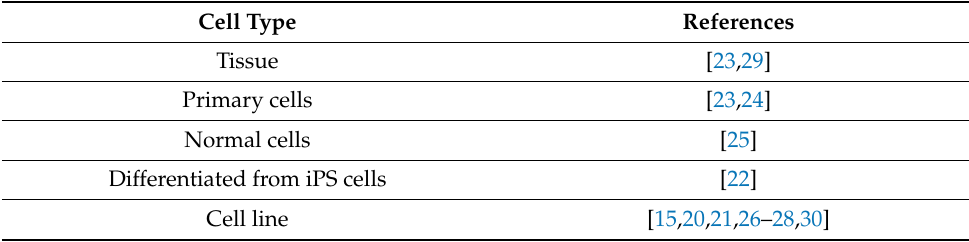
Table 3. References for the cell types lysed with Solution C and D.